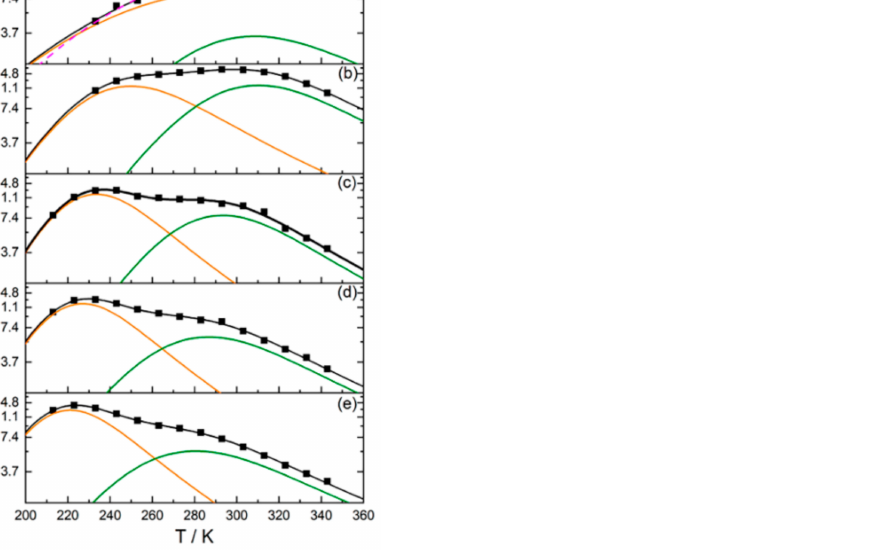
Figure 22. Temperature-dependent longitudinal relaxation rates ( R 1 ) at apparent hydration levels of ( a ) λ water = 2, ( b ) λ water = 3, ( c ), λ water = 5, ( d ) λ water = 7, and ( e ) λ water = 8 for Nafion N117. Black squares represent the experimental data and the green and orange lines represent the BPP fit of the slow (mode I) and fast (mode II) motional modes, respectively; black lines show the superpositions of both contributions. The purple dashed line in ( a ) represents the best fit assuming a single BPP model Figure 4 from. Reprinted with permission from [26]. Copyright 2019 American Chemical